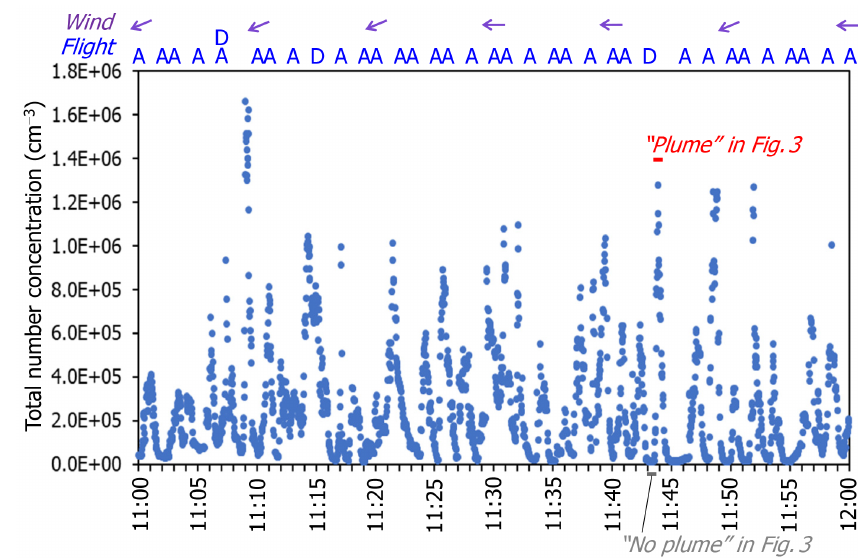
Figure 2. Time series total number concentrations of particles measured using the EEPS between 11:00 and 12:00 on 15 February 2018. One second data are shown. The letters “D” and “A” indicate the departure and arrival times of aircraft fleets, respectively, reported by Narita International Airport. The time periods of the “plume” and the “no plume” events, shown in Fig. 3, are shown here as bars. Wind directions measured at the measurement site are shown as arrows. The wind speed was 3.2–4.8ms − 1 during this